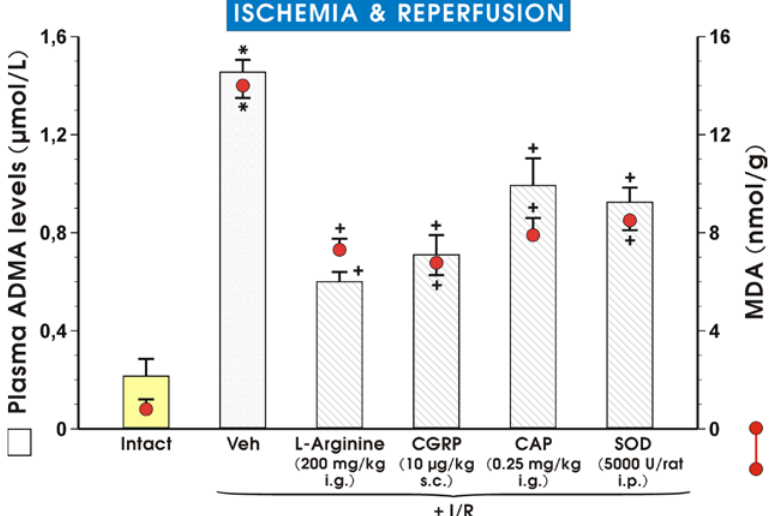
Figure 5. Plasma ADMA levels and MDA concentration in the gastric mucosa of intact rats, and those pretreated with vehicle (saline), L -arginine (200 mg/kg i.g.), CGRP (10 µg/kg s.c.), capsaicin (CAP) (applied in small protective dose (0.25 mg/kg i.g.)) or superoxide dismutase (SOD, 5000 U/rat i.p.) and exposed to 3.5 h of ischemia/reperfusion. Results are mean ± S.E.M of 7 rats per group. Significant change ( p < 0.05) as compared with the intact group, is indicated by an asterisk. A cross indicates significant change ( p < 0.05) as compared with vehicle-pretreated rats exposed to 3.5 h of